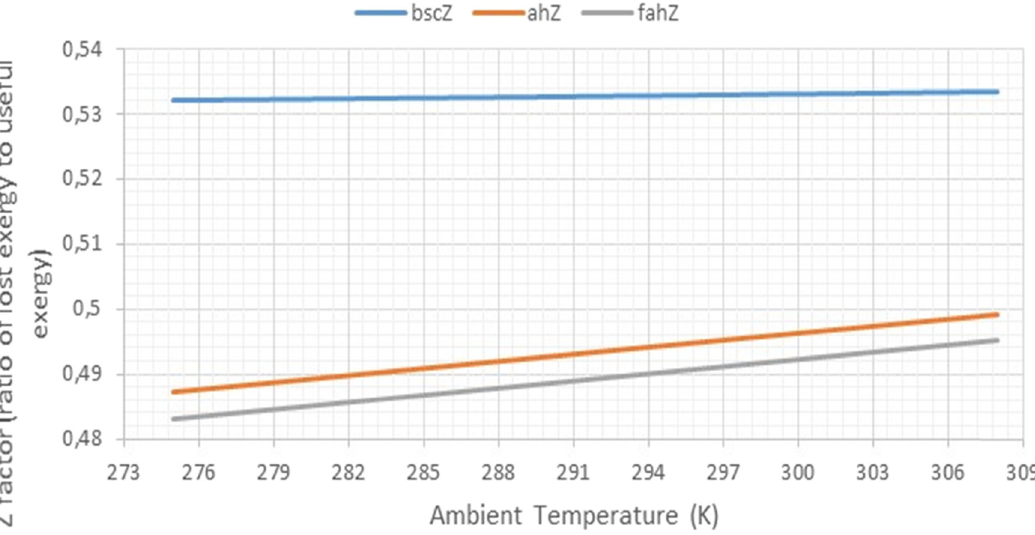
Figure 4: Variation of the Z factor ( ratio of lost exergy to useful exergy ) with the ambient temperature for bsc, ah and fah cogeneration